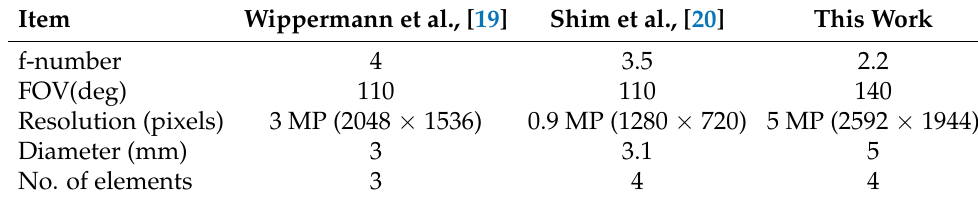
Table 5. Performance